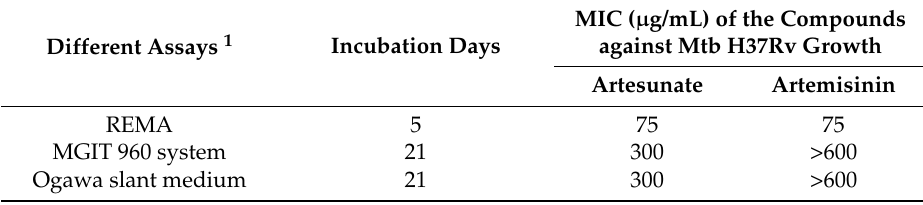
Table 2. Minimum inhibitory concentration (MIC) values of artesunate and artemisinin against the growth of Mtb H37Rv for different incubation periods.